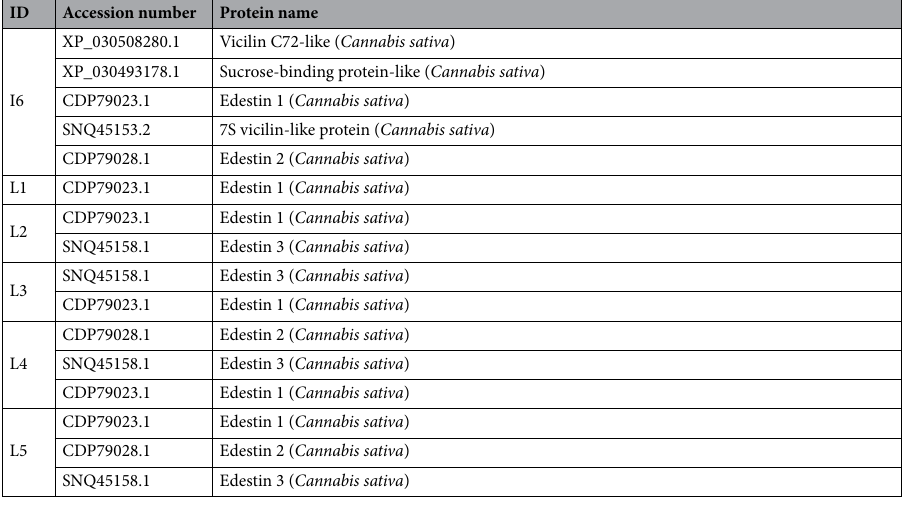
Table 4. Proteins identified after MS/MS analysis of total protein extracts from hemp seeds of Futura75 and Finola varieties analyzed by SDS-PAGE. Band identificative name (ID), accession number, protein name and organism are